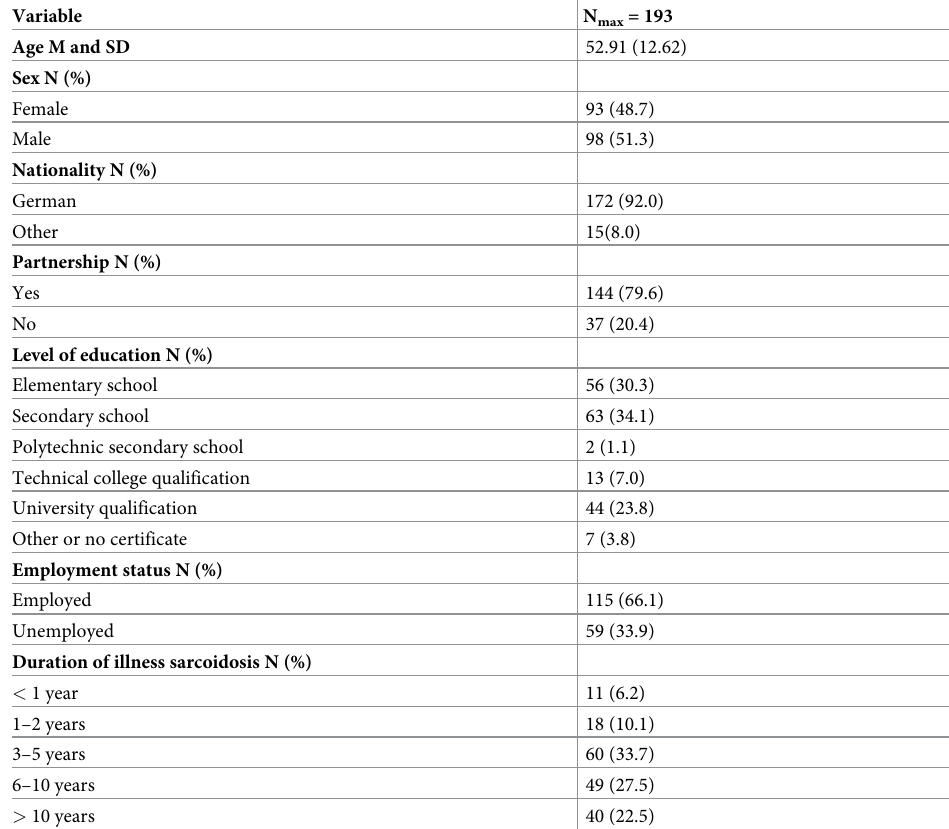
Table 1. Patient